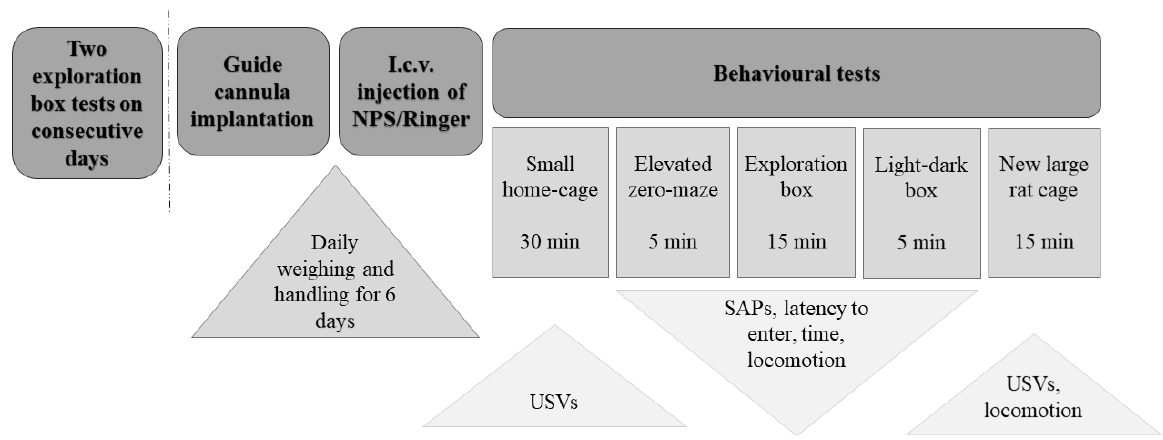
Figure 1. The general timeline of experimental procedures. I.c.v.: intracerebroventricular; NPS: neuropeptide S; SAPs: stretch-attend postures; USVs: ultrasonic vocalizations.